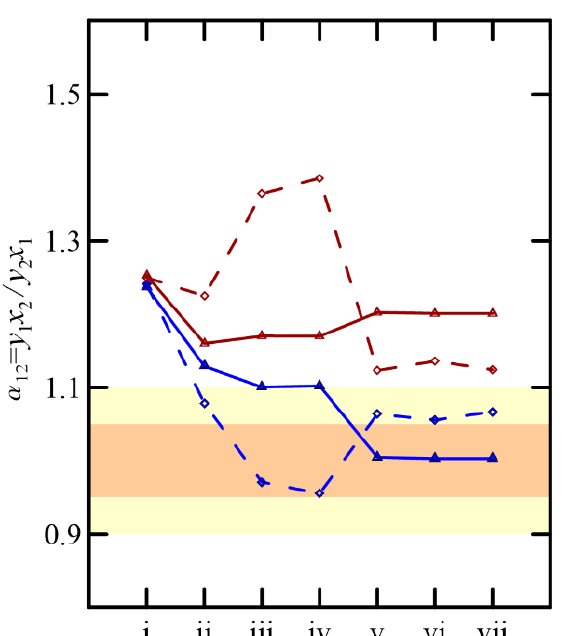
Figure 11. Minimum (----) and maximum limits (----) of the relative volatility estimated with UNIFAC (continuous) and COSMO-RS (dashed lines). Distillation not recommended, complex sepa- ration .